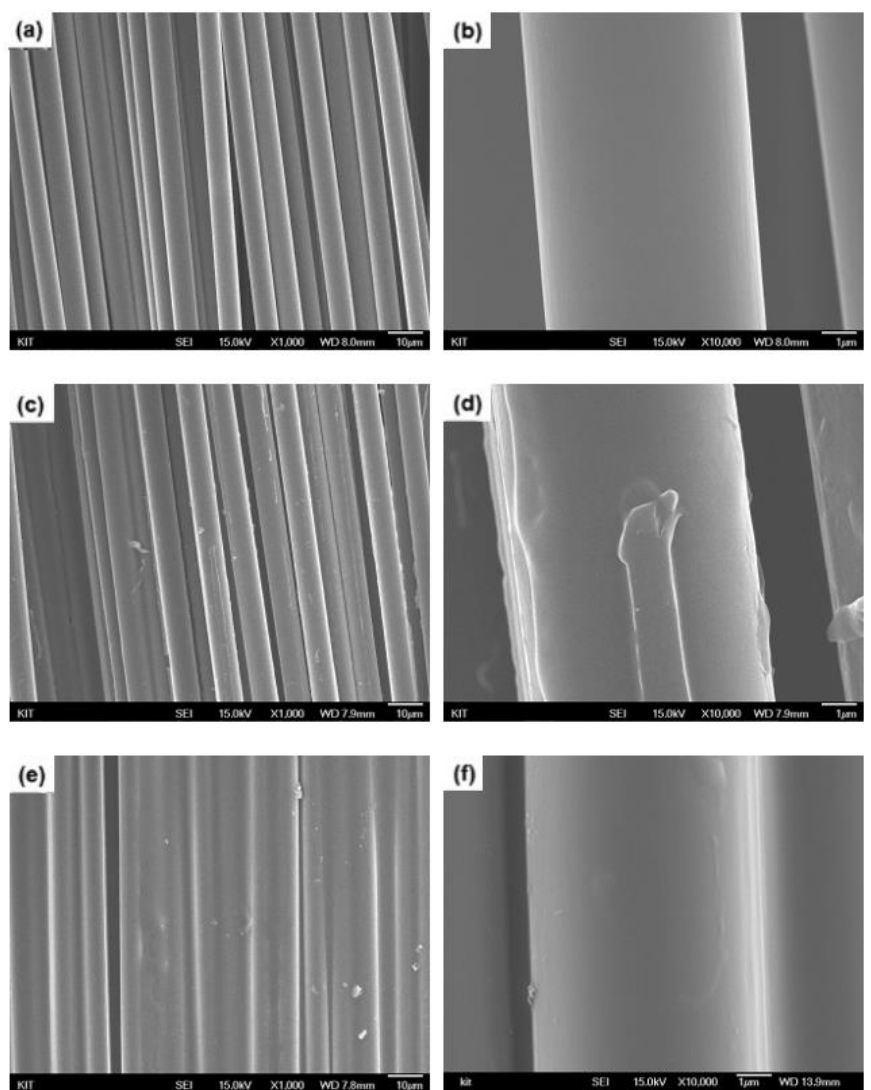
Figure 2. SEM micrographs ( a , c , e : × 1000, b , d , f : × 10,000) showing the surfaces of ( a , b ) (epoxy) single- sized carbon fiber, ( c , d ) (epoxy + epoxy) dual-sized carbon fiber, and ( e , f ) (epoxy + PU) dual-sized carbon